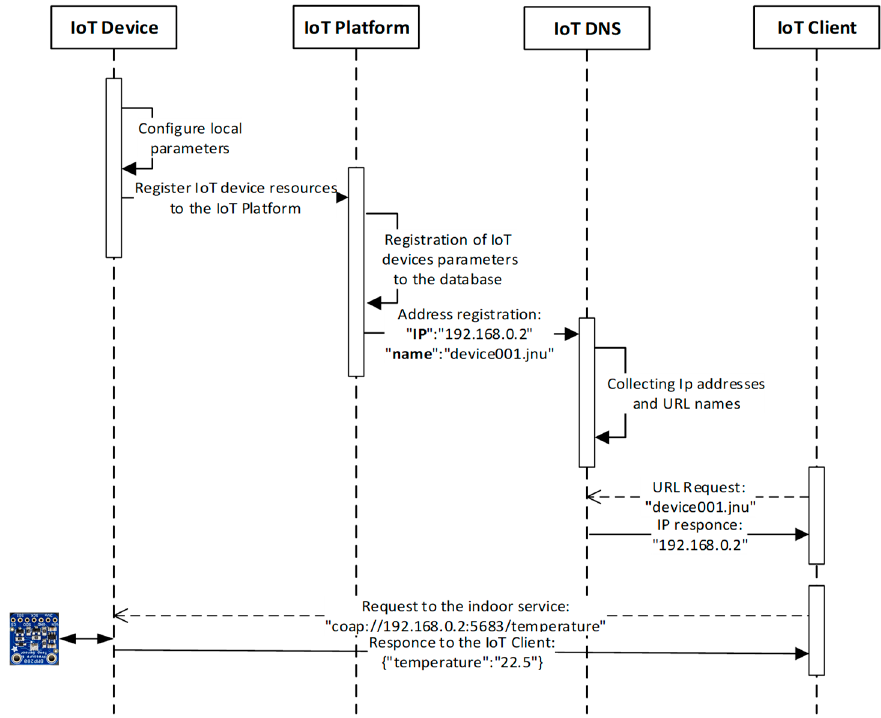
Electronics 2019 , 8 , x FOR PEER REVIEW Figure 2. Sequence diagram of the proposed Internet of Things (IoT) device auto-registration.